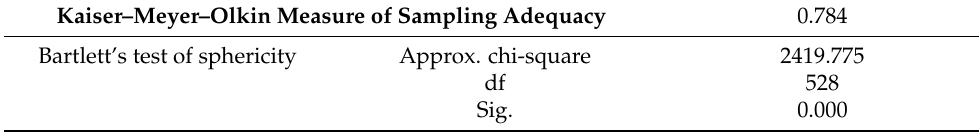
Table 3. Sampling adequacy